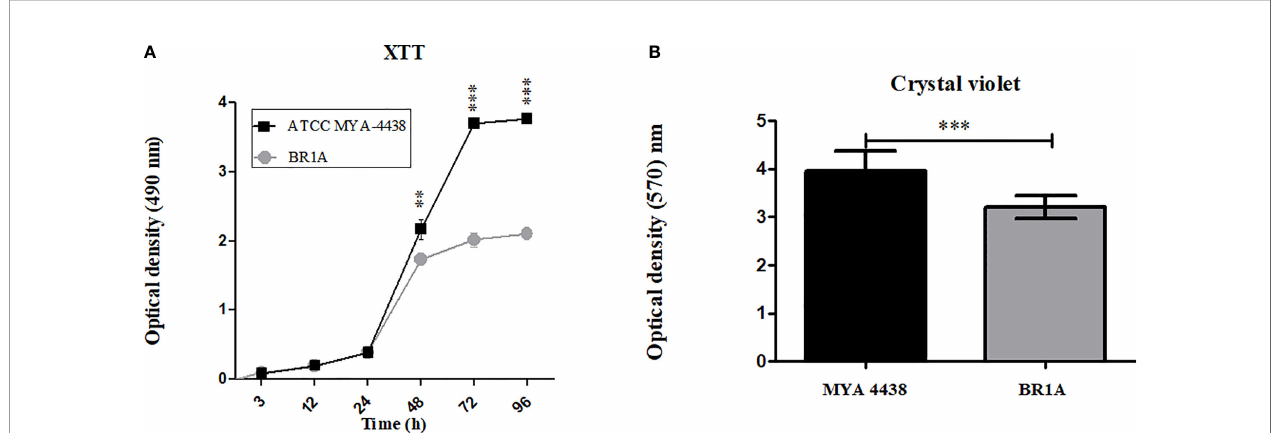
FIGURE 1 | T. rubrum ATCC MYA-4438 strain forms stronger bio fi lms than the clinical isolate BR1A strain. (A) Kinetics of T. rubrum bio fi lm formation in 96-well plates determined by XTT reduction assay. (B) Quanti fi cation of the biomass of mature T. rubrum bio fi lms after 72 h incubation was performed using crystal violet staining. For panels a and b, each time point denotes the average of 3 independent wells. Error bars indicate standard deviations. p values (**p < 0.01; ***p < 0.001) were calculated by student ’ s t test